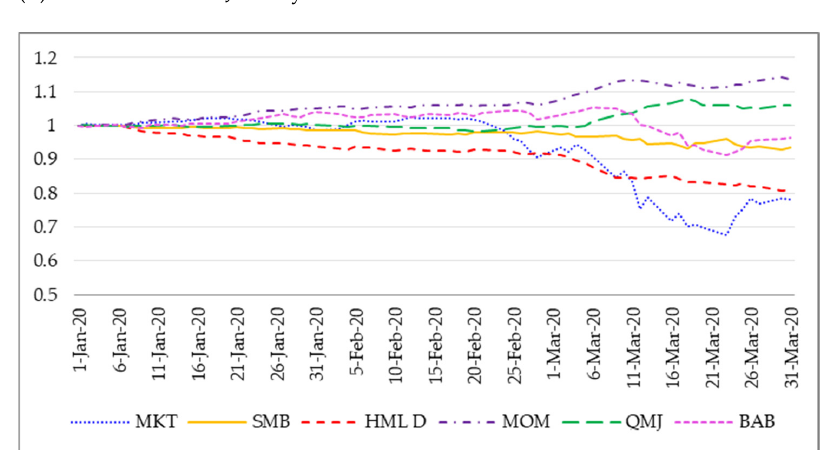
Figure 5. Cumulative Returns: Global Index. This figure displays the time series behavior of the cumulative returns of the different risk factors along two subsample periods: The Great Recession ( a ) and the COVID-19 crisis ( b ). See notes in Table 1 for the definition of the factors.